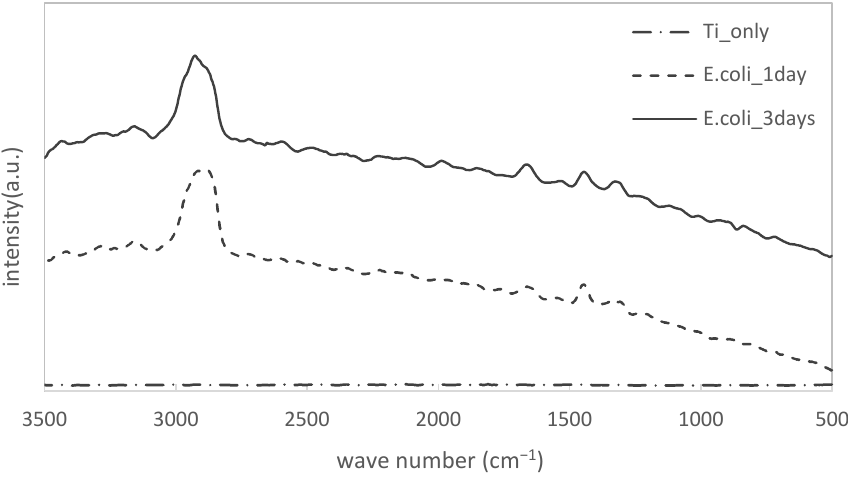
Figure 2. Change of Raman shifts for titanium specimens immersed in LB media filled with E. coli .